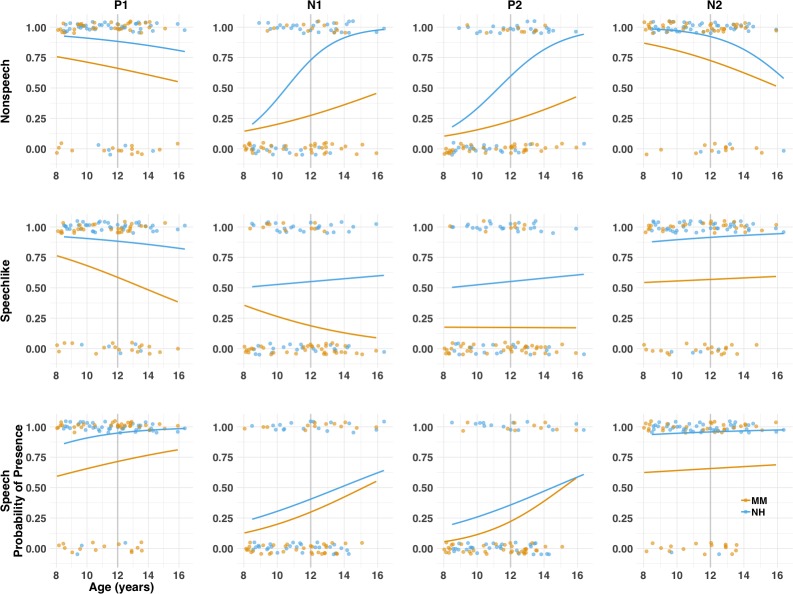
Probability of presence of the LAER components (P1, N1, P2, N2) for each group (MM vs. NH) as a function of age (cross-sectional study).Individual (circles) and group (lines) data are shown for each condition for the MM (orange) and NH (blue) groups. At the individual level, components were either present (probability = 1) or absent (probability = 0). Solid lines result from a logistic regression fitting a general linear model with age as a predictor and presence/absence of the component as the outcome variable. Note that for illustrative purposes, age is represented here as a continuous variable, but was treated as a categorical variable (Y vs. O) in the analyses (see main text). The grey vertical lines on each subplot represent the median age split into the Y (left of the line) and O (right of the line) age bands. Across ages and conditions, children with MMHL were less likely to show present LAER components than their NH peers.